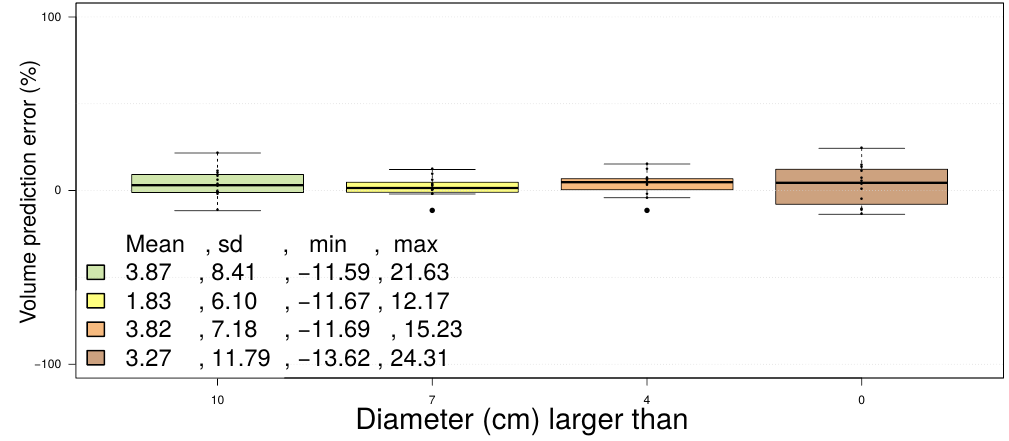
Figure 14. Box plots of the relative volume prediction error for P. massoniana . From left to right increasingly thinner branches are included in the analysis.